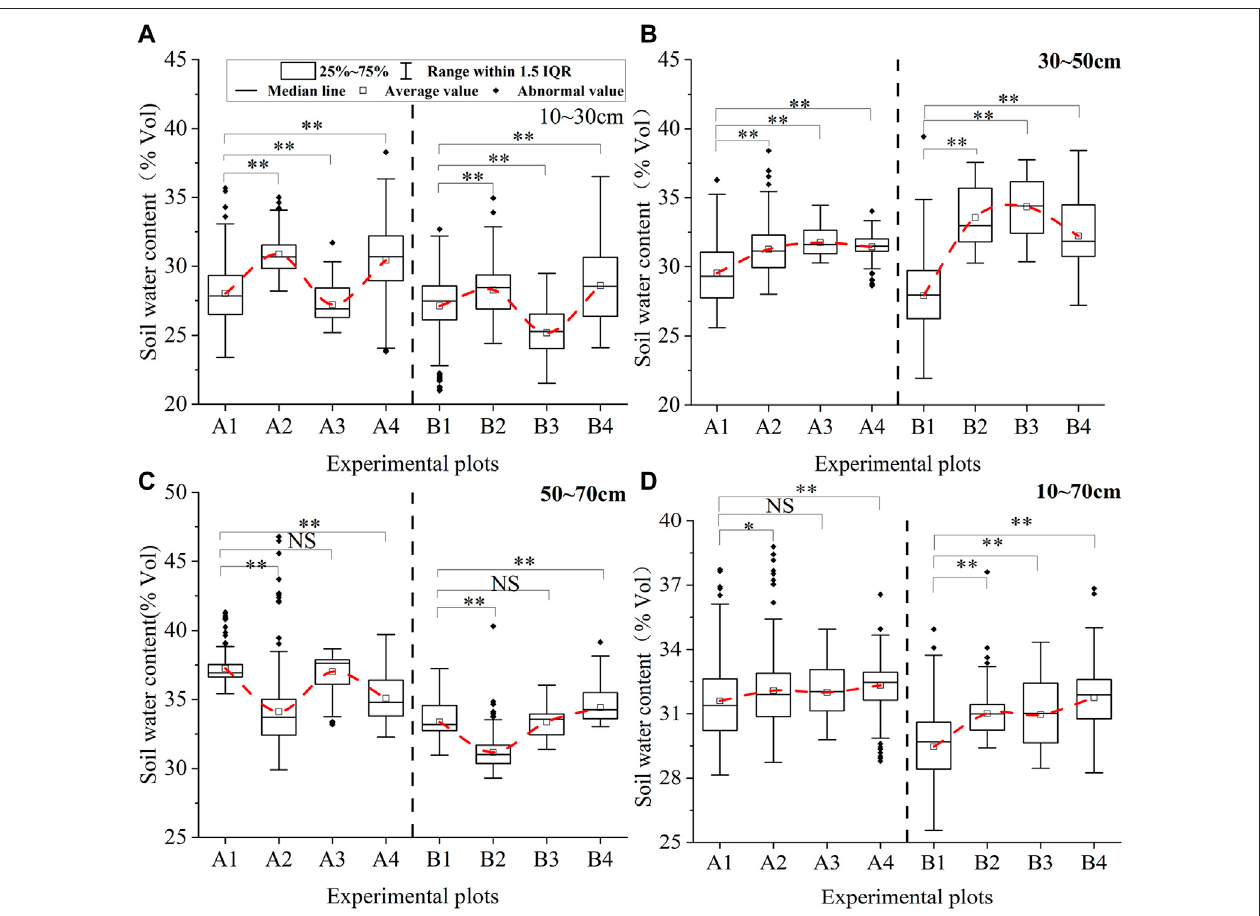
FIGURE9| Variations ofsoilwatercontentindifferentdepths. (A-D) Thedifferentdepths ofthesoil,*represents asigni fi cantdifference instream fl owbetweenthe PFMandthecontrolplotsat α =0.05;**representsasigni fi cantdifferencebetweenthePFMandthecontrolplotsat α =0.01;NSrepresentsnosigni fi cantdifferenceat α =